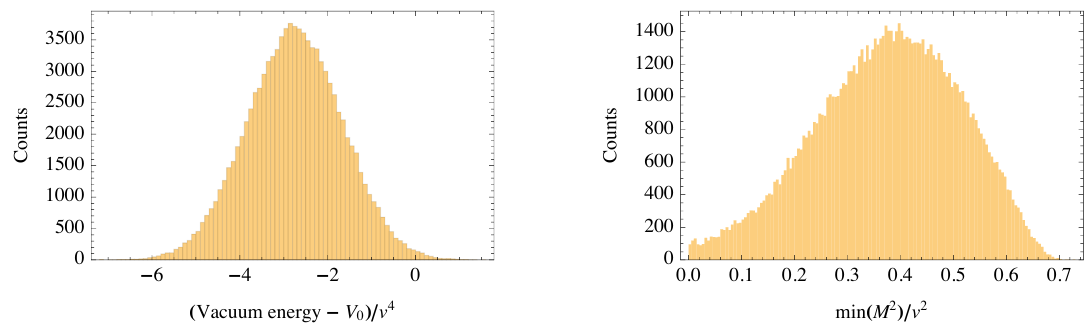
Figure 2 . We consider N = 100 scalars with the bi-quadratic potential of eq. (2.7) for quartics (cid:21) ij as in eq. (2.10), with comparable diagonal eigenvalues (cid:21) i (cid:25) 1 extracted from a Gaussian, mixing angles (cid:18) (cid:24) 0 : 1, vacuum expectation values v i = v . We add cubic terms V odd = O (0 : 1) v(cid:30) 3 compute 10 5 random local minima and show their distribution of the vacuum energy (left plot) and of the lightest scalar squared mass (right